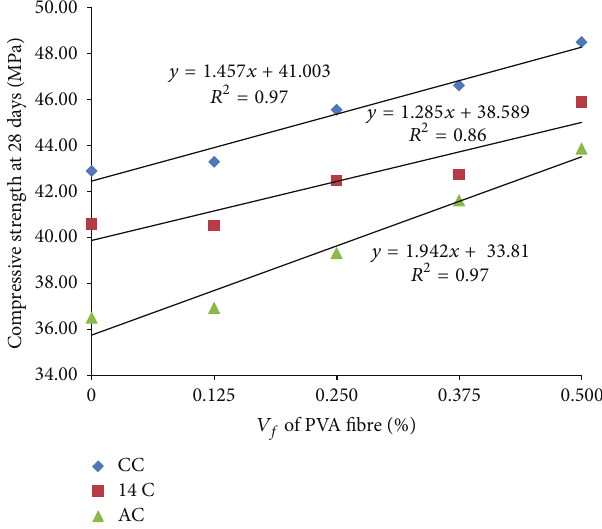
Figure 8: Relationship between PVA fiber volume fraction and compressive strength under different curing conditions on the 28th